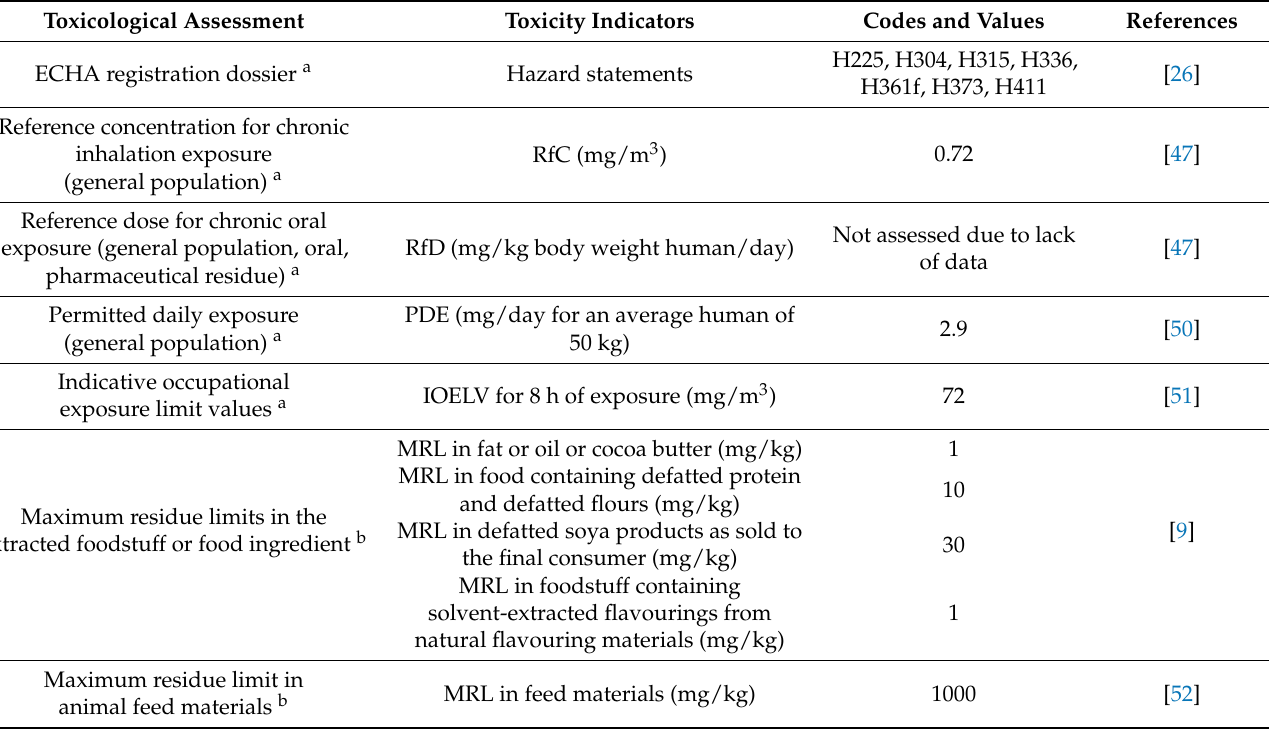
Table 2. Hexane reference limits and toxicological